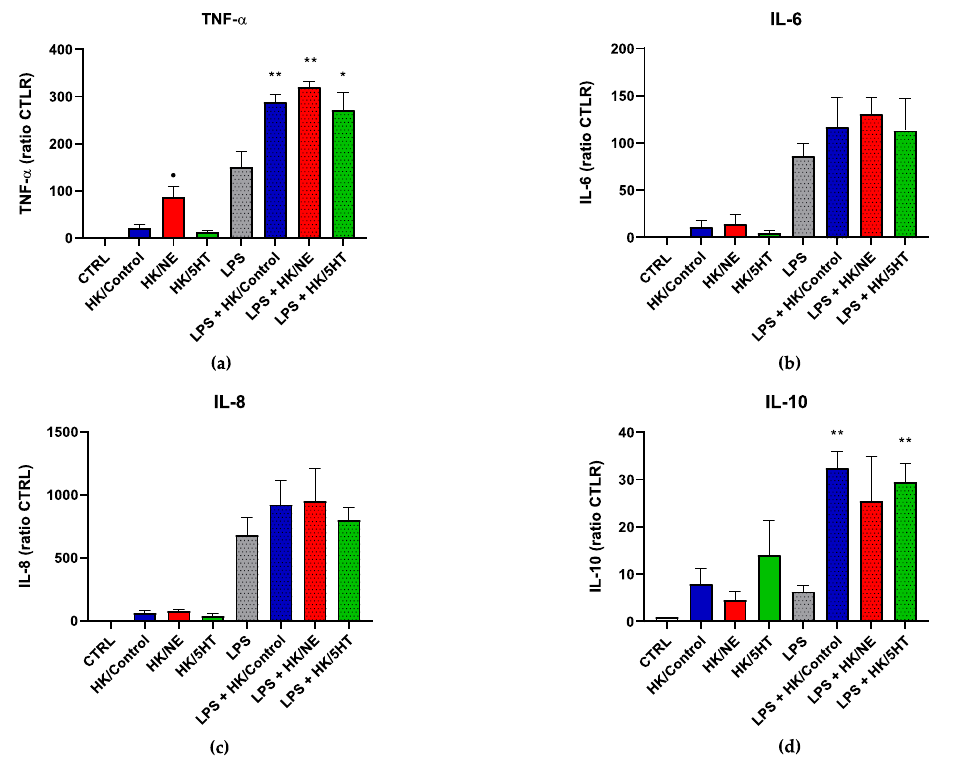
Figure 5. Cytokines’ quantification in DCs culture supernatant after 40 h incubation with HK/Control (blue), HK/NE (red) and HK/5HT (green). Untreated DC supernatants represent the negative control (CTRL). Results are expressed as ratio of CTRL ± SEM. ( a ) TNF-a; ( b ) IL-6; ( c ) IL-8; ( d ) IL-10.